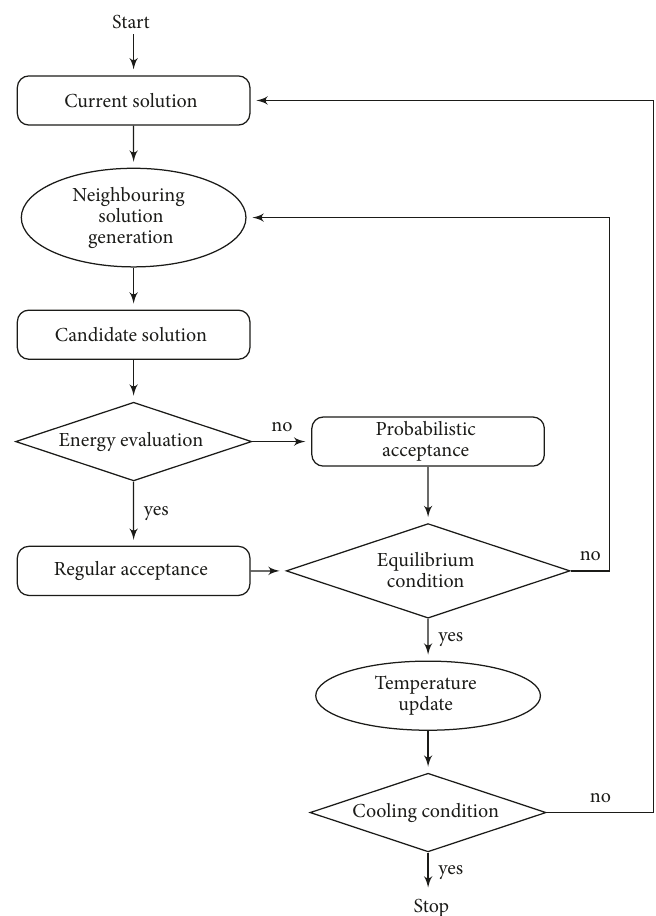
Figure 1: Flowchart of the mono-objective simulated annealing